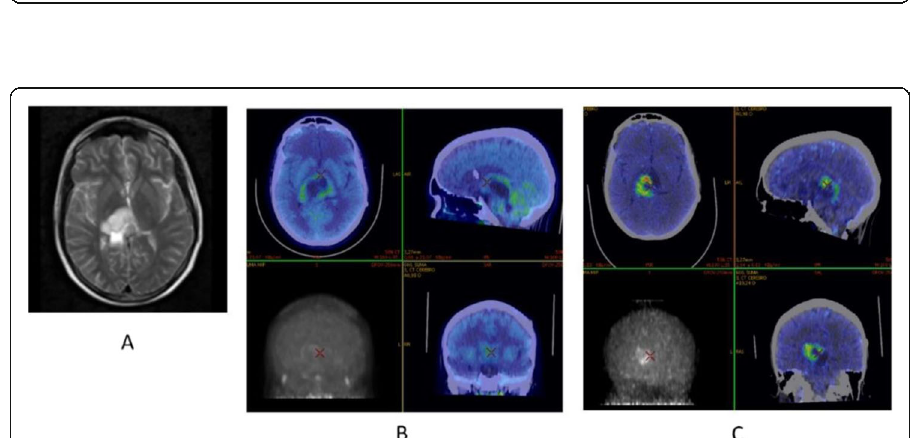
Fig. 67 18 F-FMISO, characterisation of a brain lesion and comparison to 11 C-methionine. Clinical history : 15 y.o. boy. High-grade glioblastoma, sub-totally removed and treated with radiotherapy. MRI: persistence of expansive lesion in thalamic area ( a ). PET/CT findings : 11 C-methionine shows peripheral uptake in the right thalamus tumour, probably related to residual viable tumour or relapse despite its low intensity ( b ). 18 F- FMISO PET/CT showed hypoxic area in previously methionine uptake described lesion ( c ), suggesting a